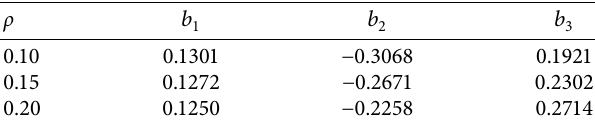
Figure 8: Variations in the plastic Poisson’s ratio with the axial true strain. Table 5: Fitting results of the parameters in equation (14).